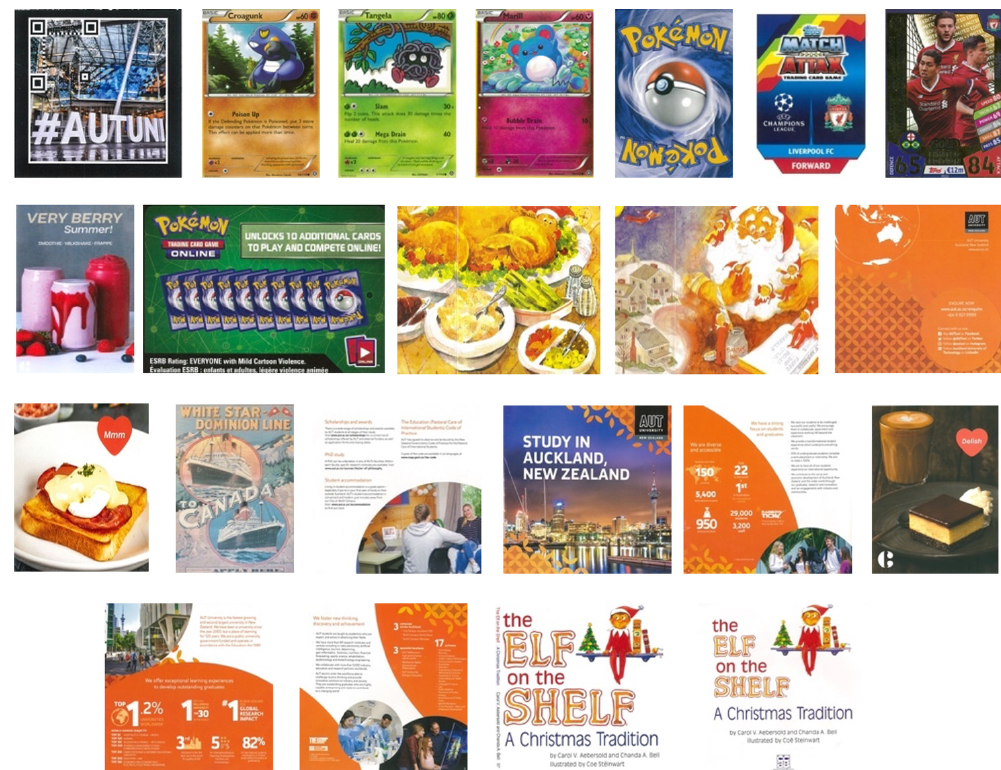
Figure 9. The target marker figures. First row: aut, coragunk, tangela, marill, pokemon, match mattax, liverpool fc. Second row: milkshake, pokemon online, book food page, book santa page, aut last page. Third row: bread, ships, aut fifth page, aut first page, aut fourth page, chocolate. Last row: aut second page, aut third page, book cover page, book first page. Table 2. Details of target markers and their label name, width, height and number of generated samples in the